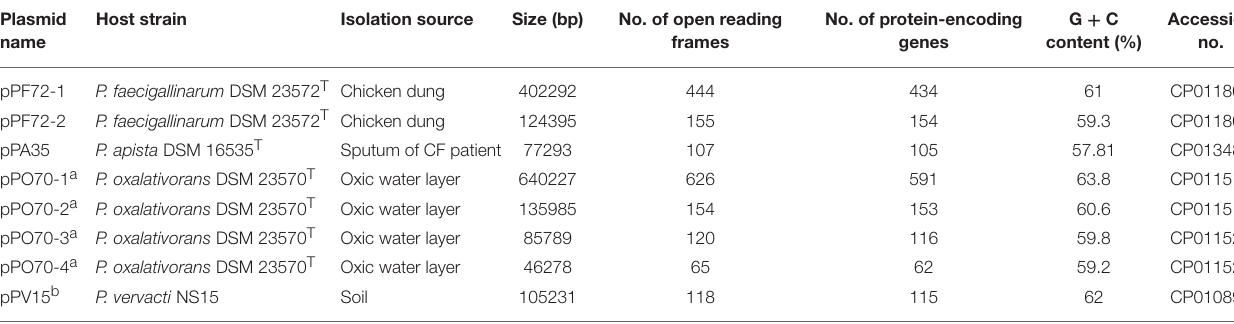
TABLE 1 | General plasmid